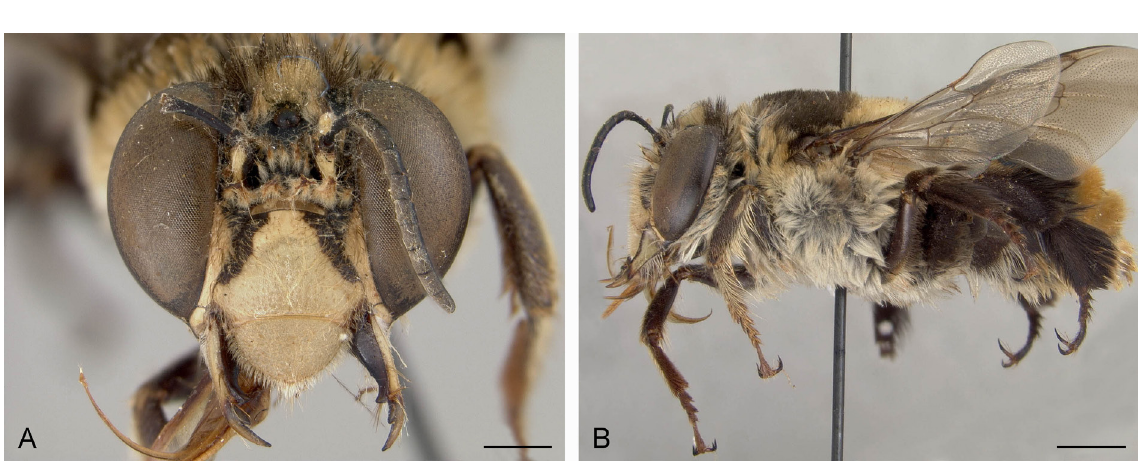
Fig. 3. Centris disclusa Cockerell, 1922, holotype, ♂ (NMNH; USNM ENT 00534192). A . Frontal view. B . Habitus, lateral view. Scale bars: A = 1 mm; B = 2